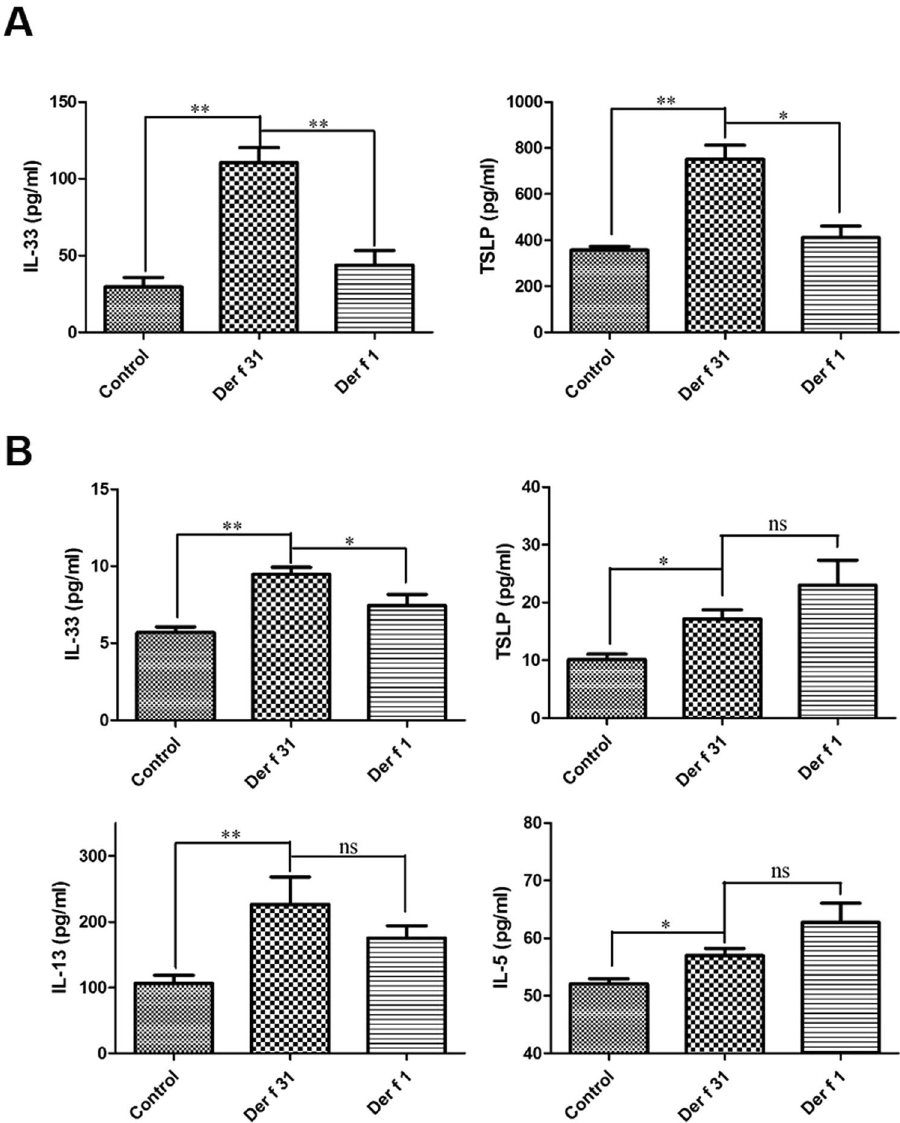
Figure 7. The cytokines from BALF and lung homogenates. ( A ) The cytokines in BALF. The lung tissues were homogenized by sonication on ice and then centrifuged to obtain supernatants to test the expression levels of cytokines. ( B ) The cytokines from lung homogenates. The results are means ± SEMs (n = 4–6), processed with GraphPad software. The significant differences between two groups were tested by two-tailed T-test. * p < 0.05. ** p < 0.01. *** p < 0.001. ns, no significant